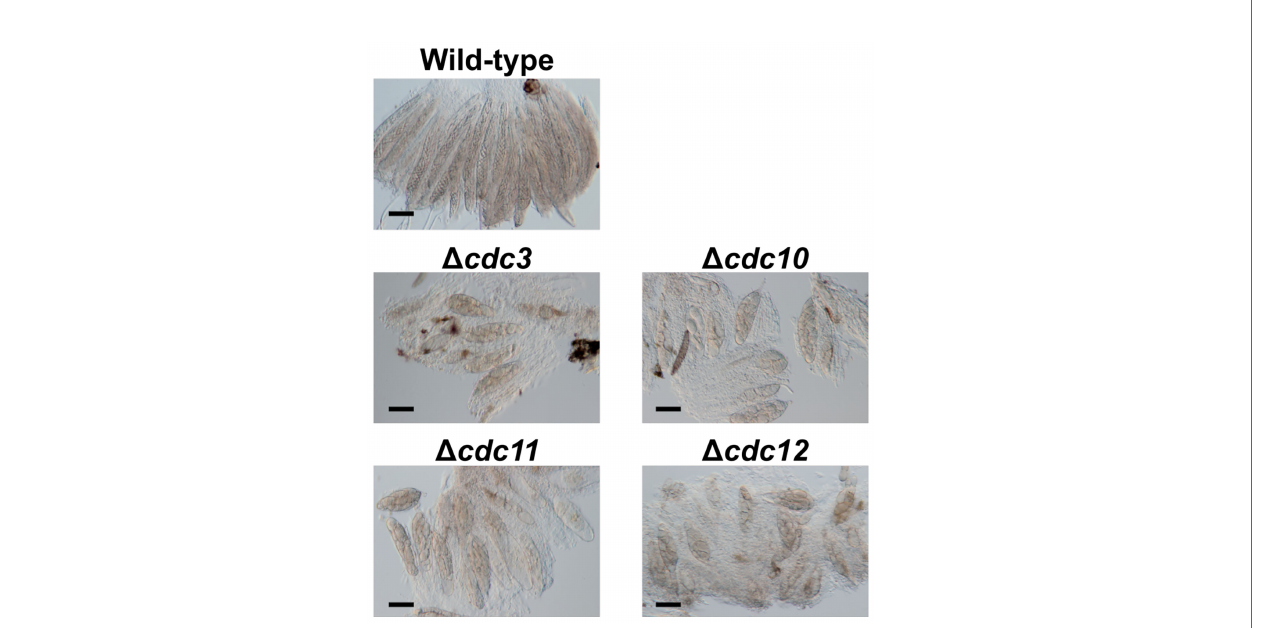
FIGURE 1 | Asci and ascospores from crosses between the null mutants of core septin genes and the wild-type strain. The null mutants of core septin genes were crossed with the wild-type strain. After 4 weeks, formed pseudothecia were harvested and dissected to observe asci and ascospores. Bars : 50